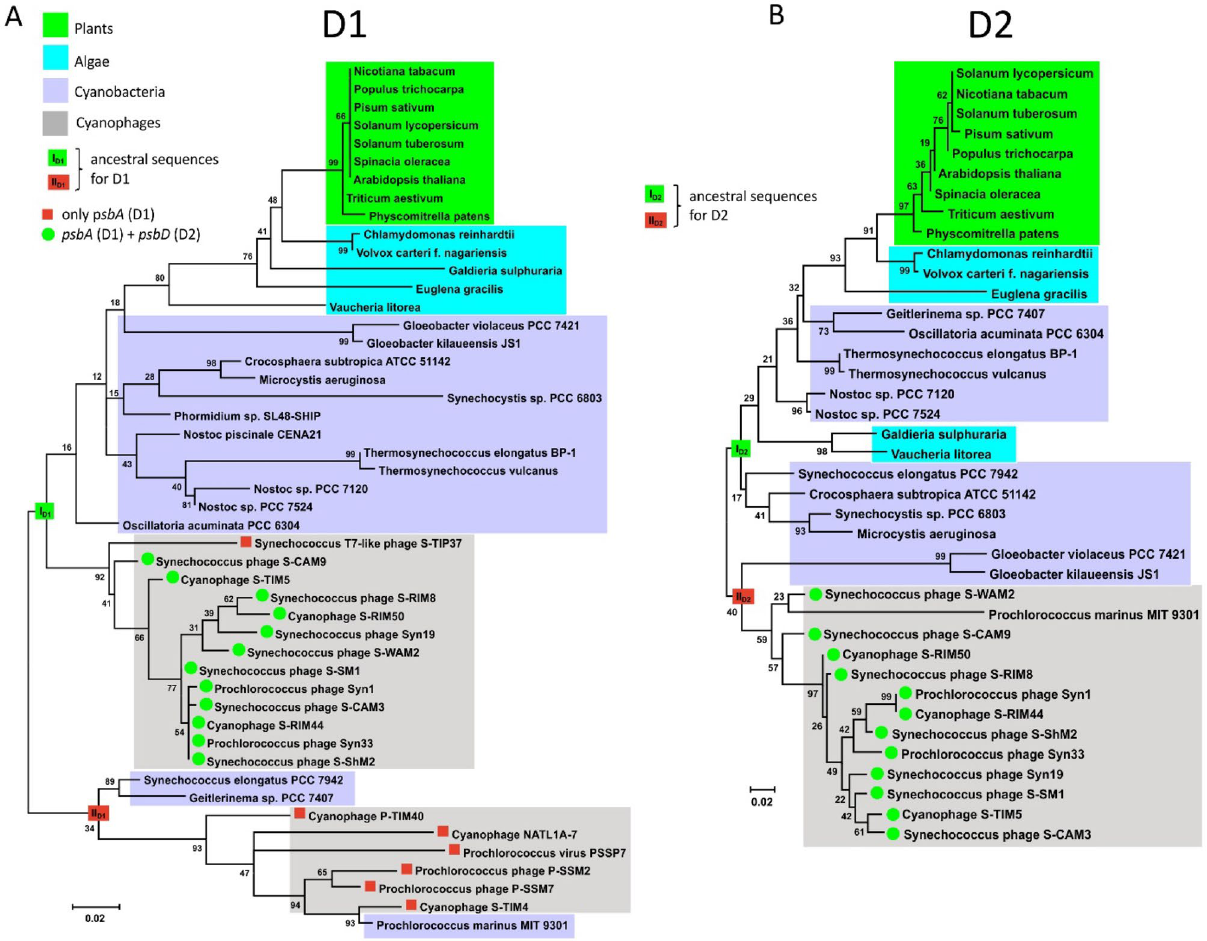
Figure 1. Phylogeny of the D1 and D2 proteins for the organism and cyanophage groups analysed in this study (Supplementary Information Notes S1 and Notes S2). ( A ) The unrooted phylogenetic tree of D1. ( B ) The unrooted phylogenetic tree of D2. The deepest nodes for reconstructing the ancestral sequences, designated I D1 and II D1 for D1 ( A ) and I D2 and II D2 for D2 ( B ), are indicated. The occurrence of psbA alone or psbA and psbD in the cyanophages is indicated. The numbers at the nodes represent bootstrap values (based on 1000 replicates). The scale shows the number of substitutions per amino acid